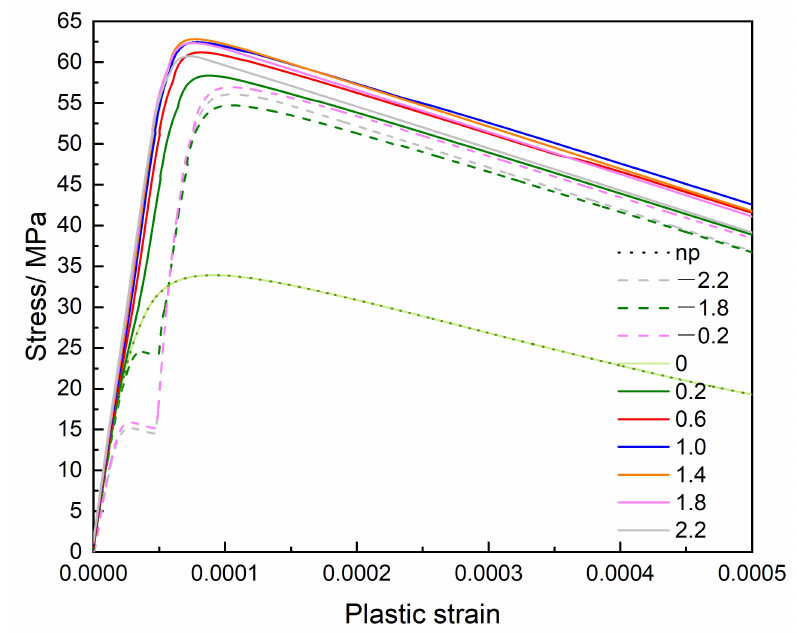
Figure 17. The stress–strain